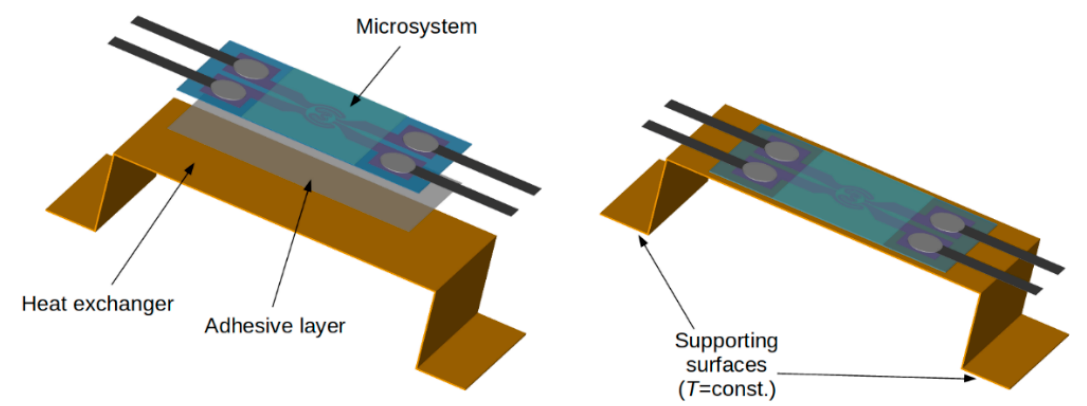
Figure 4. Integration of structure and heat exchanger for cryogenic research.